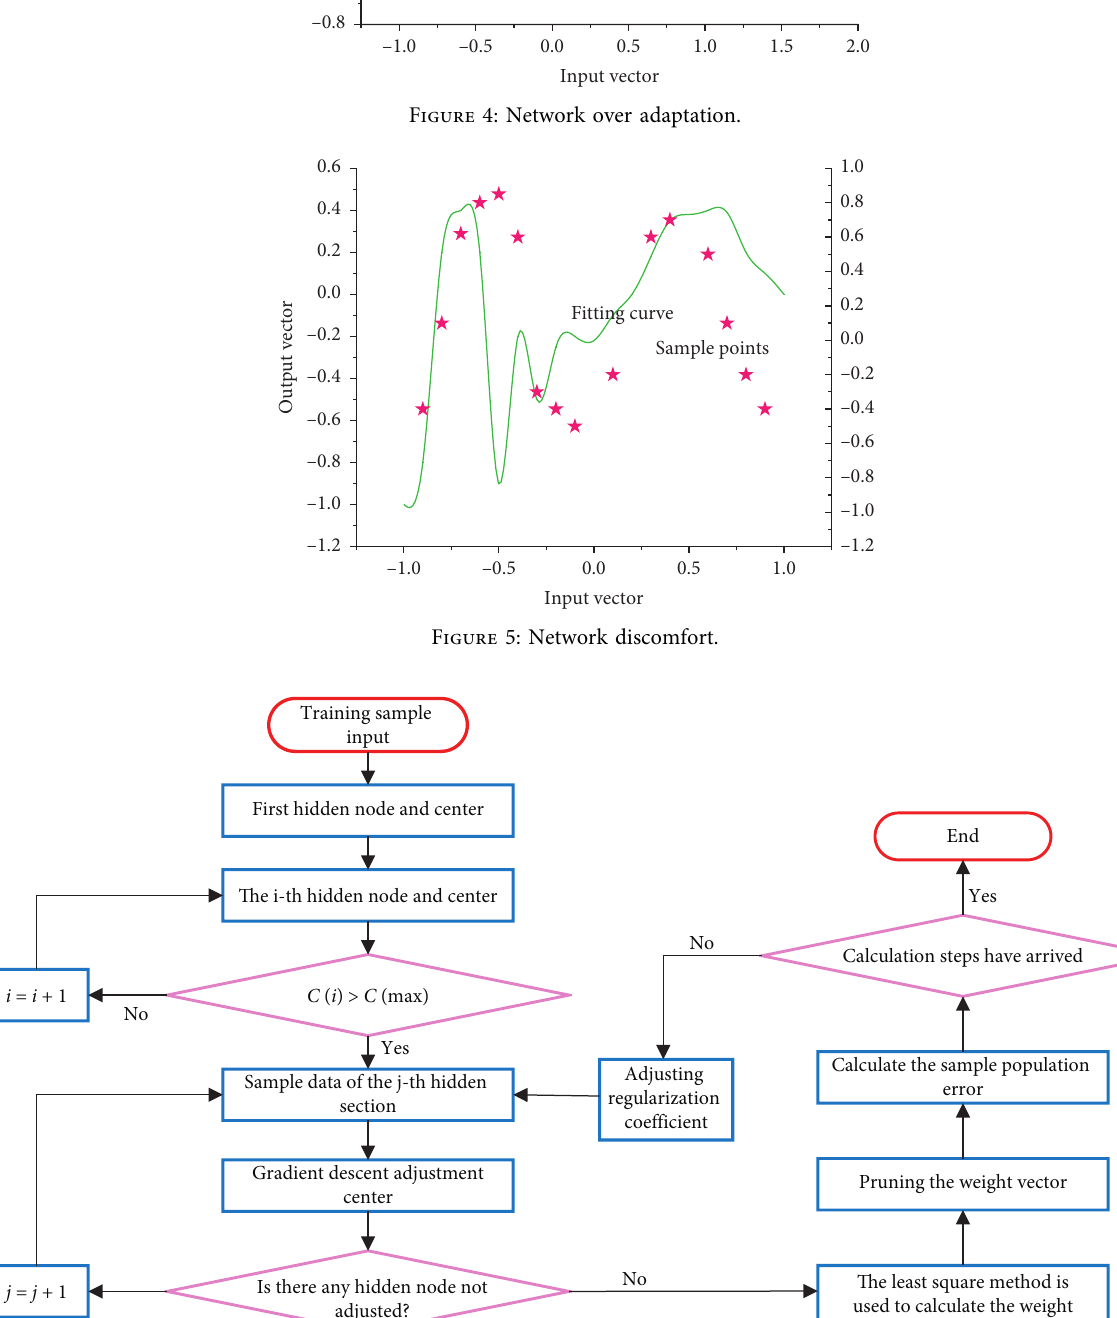
Figure 6: Training flow of RBF neural